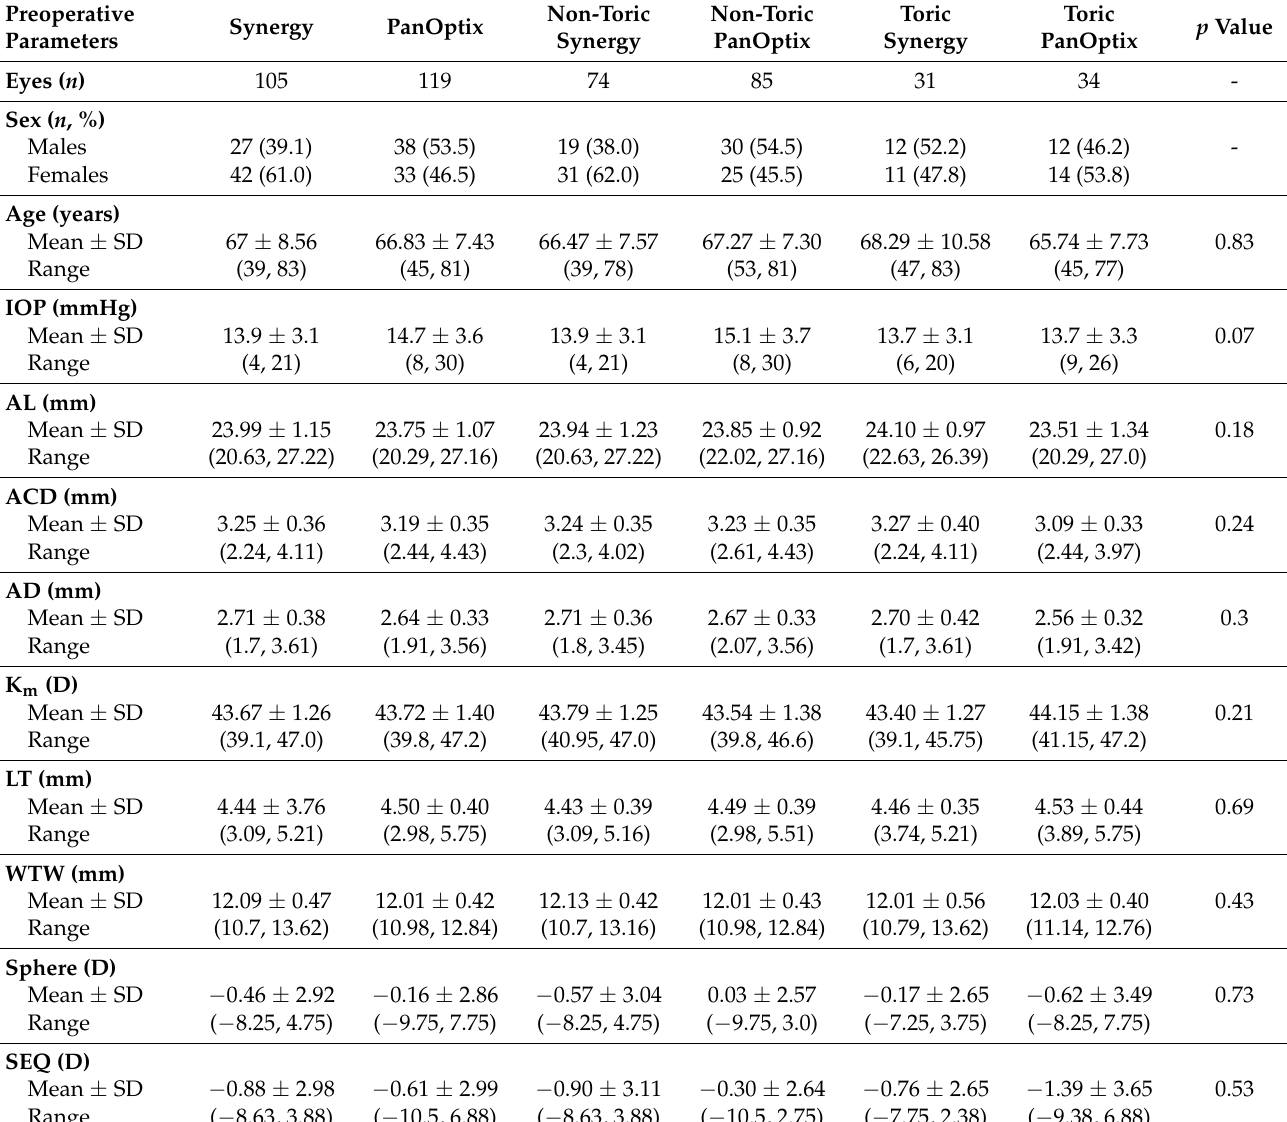
Table 1. Preoperative Patient